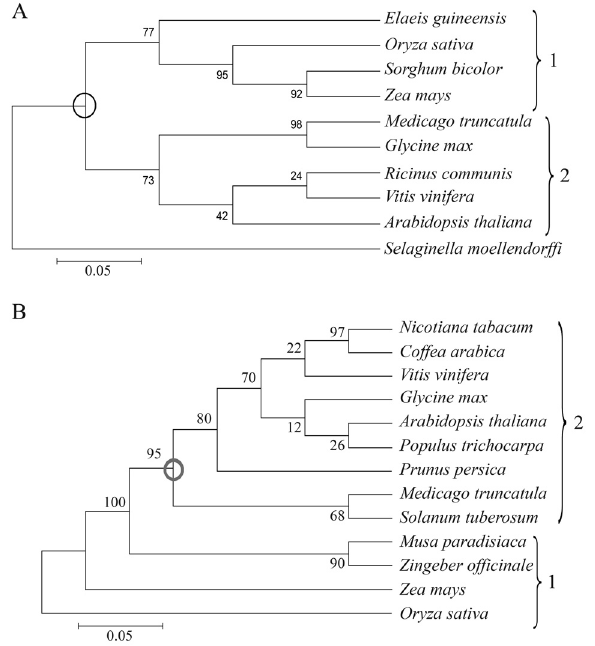
Figure 4 - Dendrograms generated after maximum parsimony analysis showing the relationships among selected plant species considering se- quences of (A) Xa21 and (B) PR-2 . Keys in (1) represent monocots and in (2) dicots. Xa21 : the circle on the root of A shows the divergence point be- tween monocots and dicots. PR-2: the circle on the root of B shows an an- cestor with a symplesiomorphic character. Numbers at the base of the branches denote bootstrap values and the bar represents the evolutionary scale.